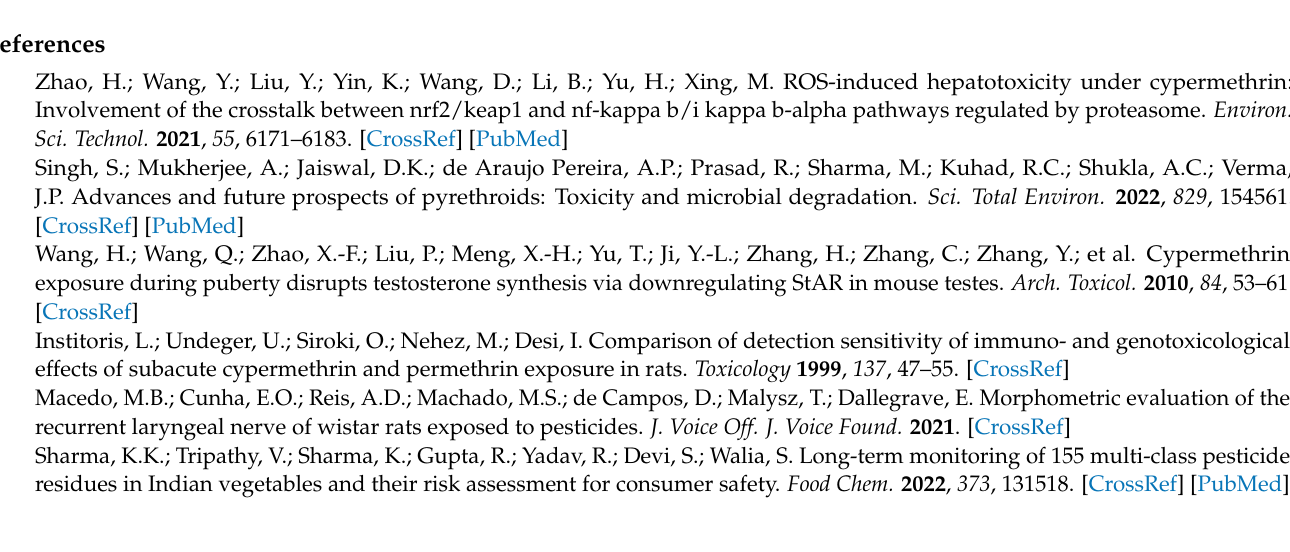
Table S2: Sensitivities of anti-CYP antibodies using hapten 1 as coating antigen; Table S3: Effect of sodium ion concentration, pH, type and content of organic solvents on sensitivity of ic-ELISA for determination of CYP; Table S4: Influence of sodium ion concentration, pH, type and content of organic solvents on sensitivity of LFIA for determination of